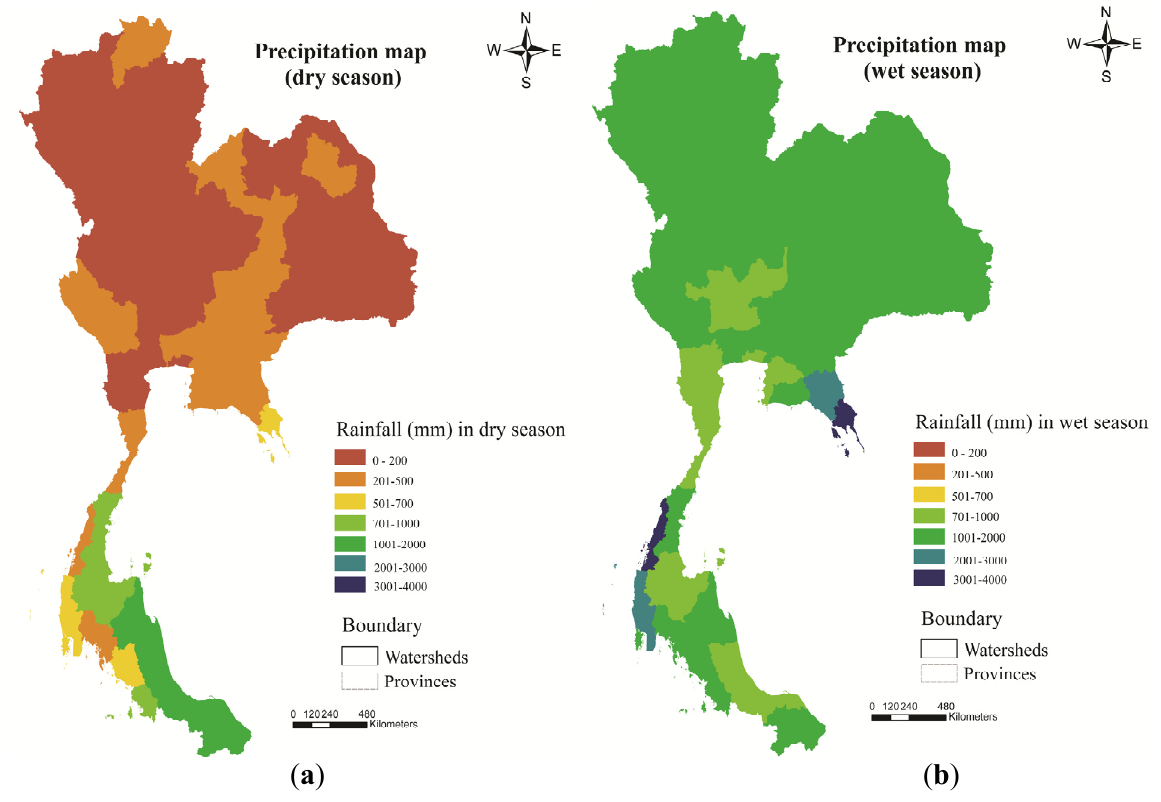
Figure 2. Precipitation maps for wet and dry seasons of Thailand. ( a ) Dry season; ( b ) Wet